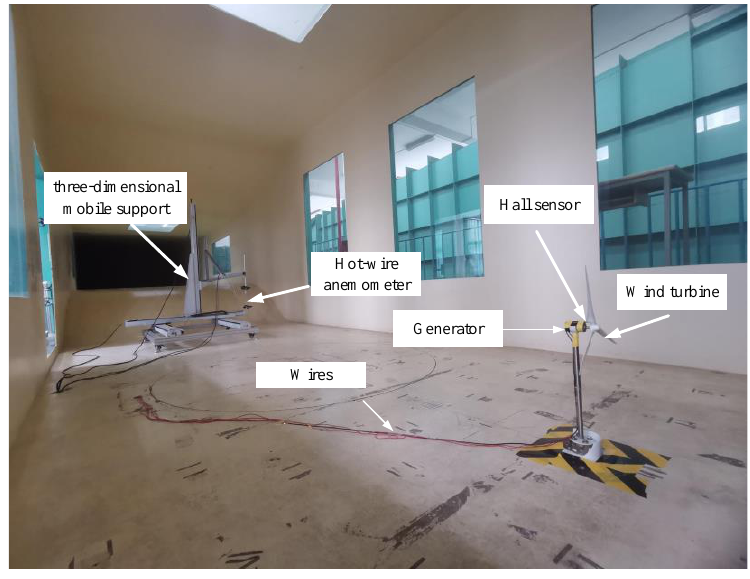
Figure 9. Measurement in the wind tunnel.